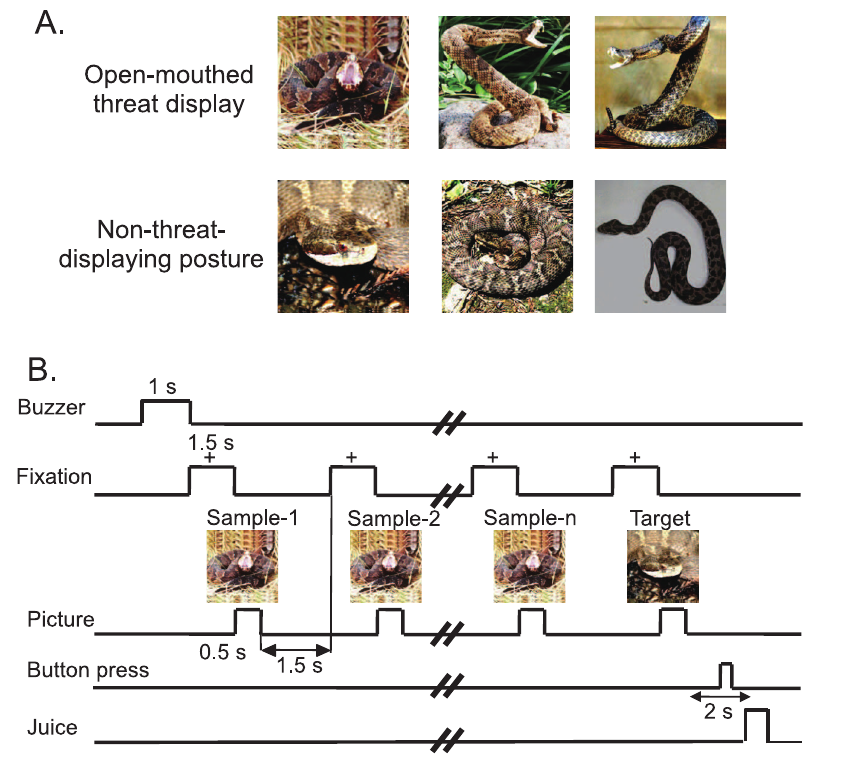
Figure 1. Visual stimuli (A) and delayed nonmatching-to-sample (DMNS) task (B) used in the present study. (A) Six photos of two categories of the stimuli including snakes in threat display and non-threat- displaying postures. (B) Stimulus sequence in the DMNS task in which stimuli were sequentially presented with a delay.